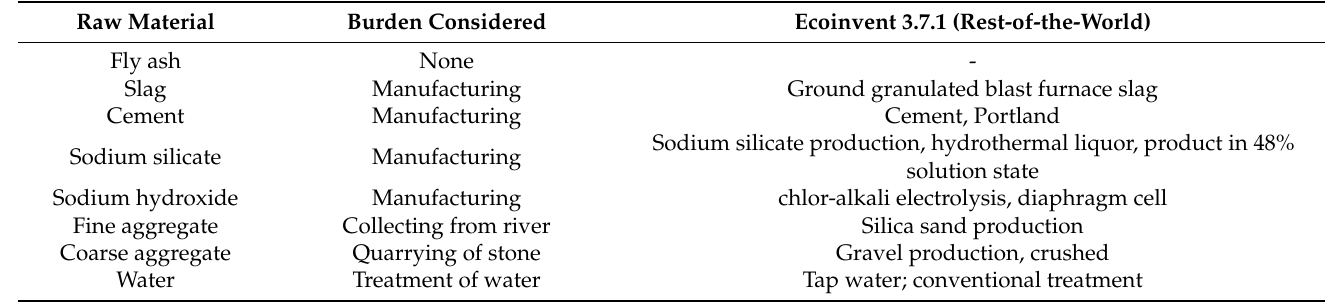
Table 4. Inventory data for raw materials.